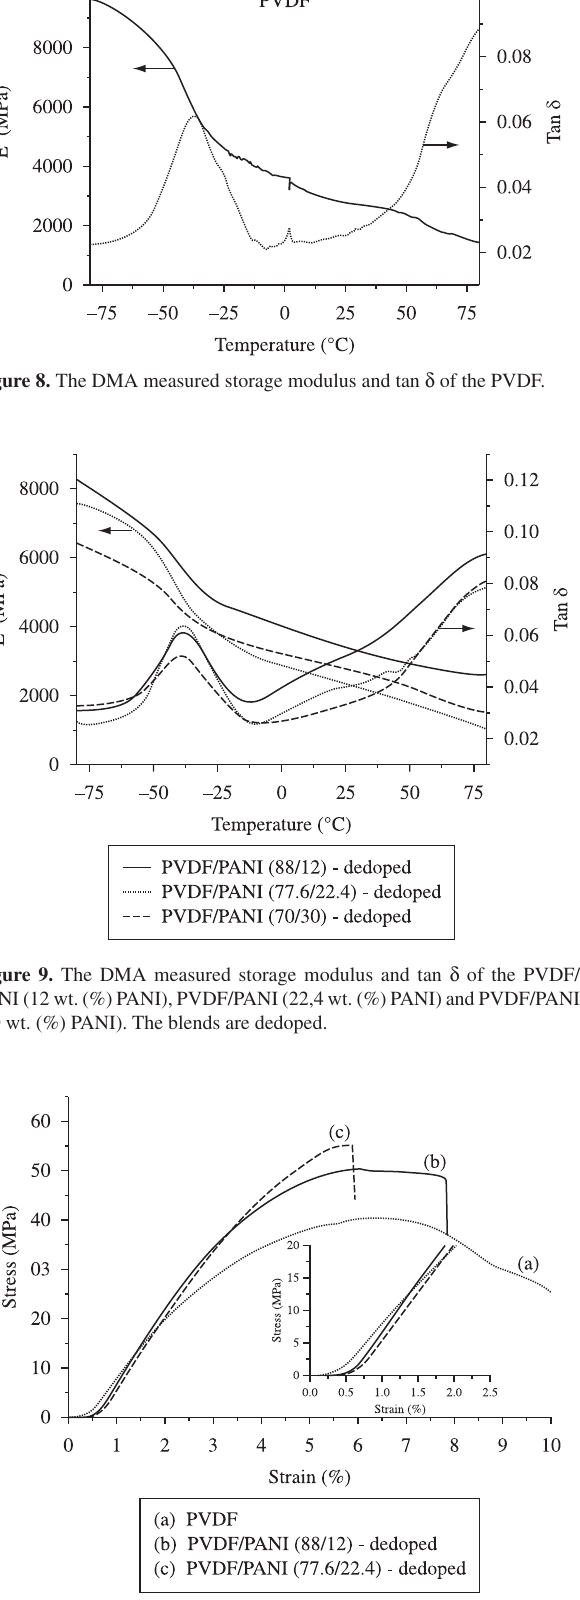
Figure 10. Stress-strain curves of: a) PVDF; b) PVDF/PANI (12 wt. (%) PANI); and c) PVDF/PANI (22,4 wt. (%) PANI). The blends were dedoped.